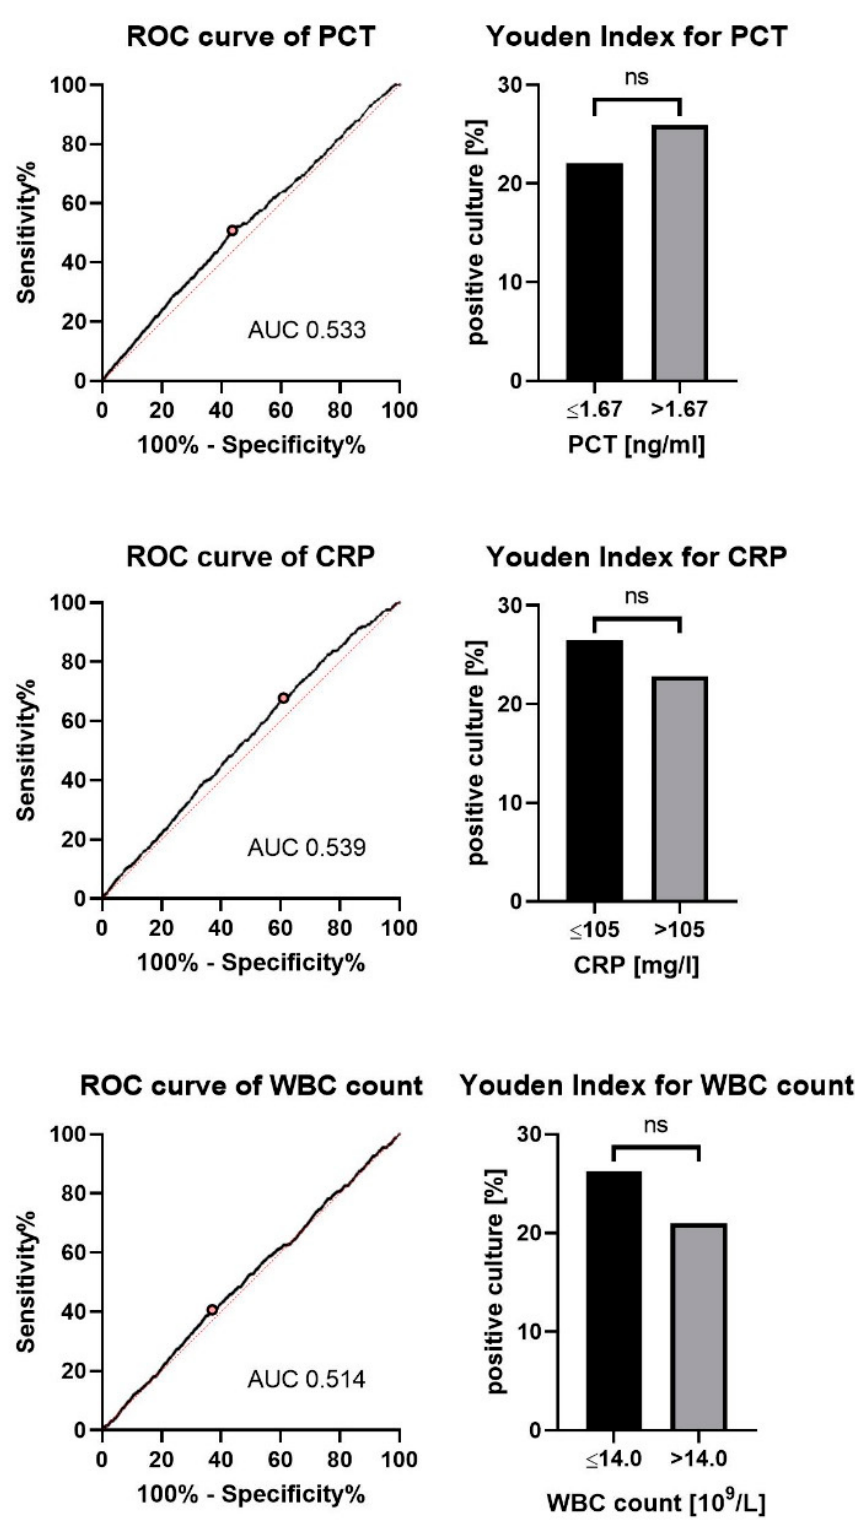
Figure 2. Markers of inflammation for the whole group. ROC curve showing the diagnostic values of PCT and CRP culture positive BAL with relevant bacteria. Best discrimination between the groups according to Youden Index is given for each marker. Abbreviations: BAL = bronchoalveolar lavage, WBC = while blood cell, CRP = C-reactive protein, PCT = procalcitonin.